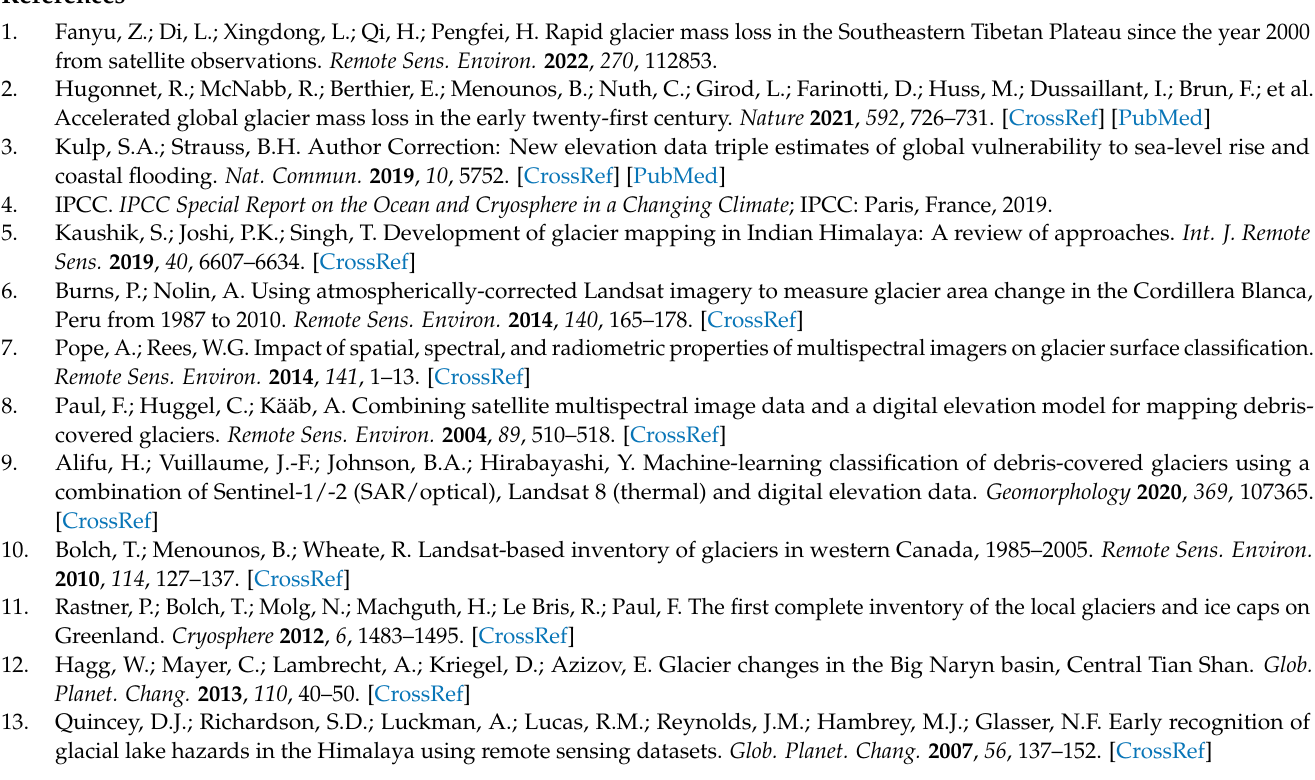
Figure S3: Comparison of glacier boundaries extracted from Landsat and GF-1 images. (a) Landsat-8 OLI image (OLI432 band compositions, 2021.10.01); (b) band ratio result (band 4 / band 6) from Landsat image; (c) RGI 6.0 data; (d) GF-1 images (321 band compositions, 2021.11.05); (e) band ratio result (band 1 / band 4) from GF-1 image; and (f) the optimized glacier boundary from (b), and corrected by RGI 6.0 data (c); Figure S4: Comparison of Landsat-based glacier boundary in 1994 (first line: (a)-(d)) and 2021 (second line: (e)-(h)). (a) Landsat TM true color image; (b) Landsat TM false-color image (Band5-red, Band4-green, Band3-blue); (c) glacier boundary calculated by band ratio method from Landsat TM; (d) final glacier boundary extraction in 1994; (e) Landsat OLI true color image; (f) Landsat OLI false-color image (Band6-red, Band5-green, Band4-blue); (g) glacier boundary calculated by band ratio method from Landsat OLI; and (h) final glacier boundary extraction in 2021; and Table S1: Statistics of glacier area changes (Landsat and